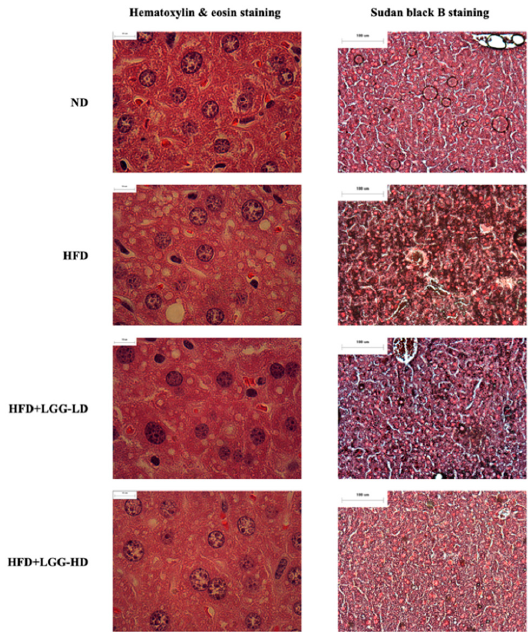
Figure 2. Effect of administration of Lactobacillus rhamnosus GG (LGG) on hepatic morphology and lipid accumulation in mice with diet-induced obesity mice. ND: normal diet; HFD: high-fat diet; HFD + LGG-LD: high-fat diet supplemented with low-dose LGG (10 8 CFU / mouse / day); HFD + LGG-HD: high-fat diet supplemented with high-dose LGG (10 10 CFU/mouse/day).